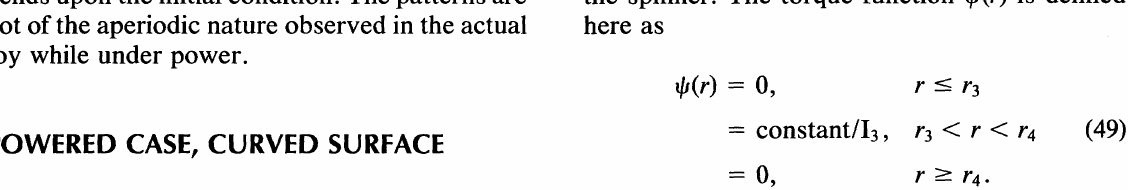
FIGURE 7 Unpowered case